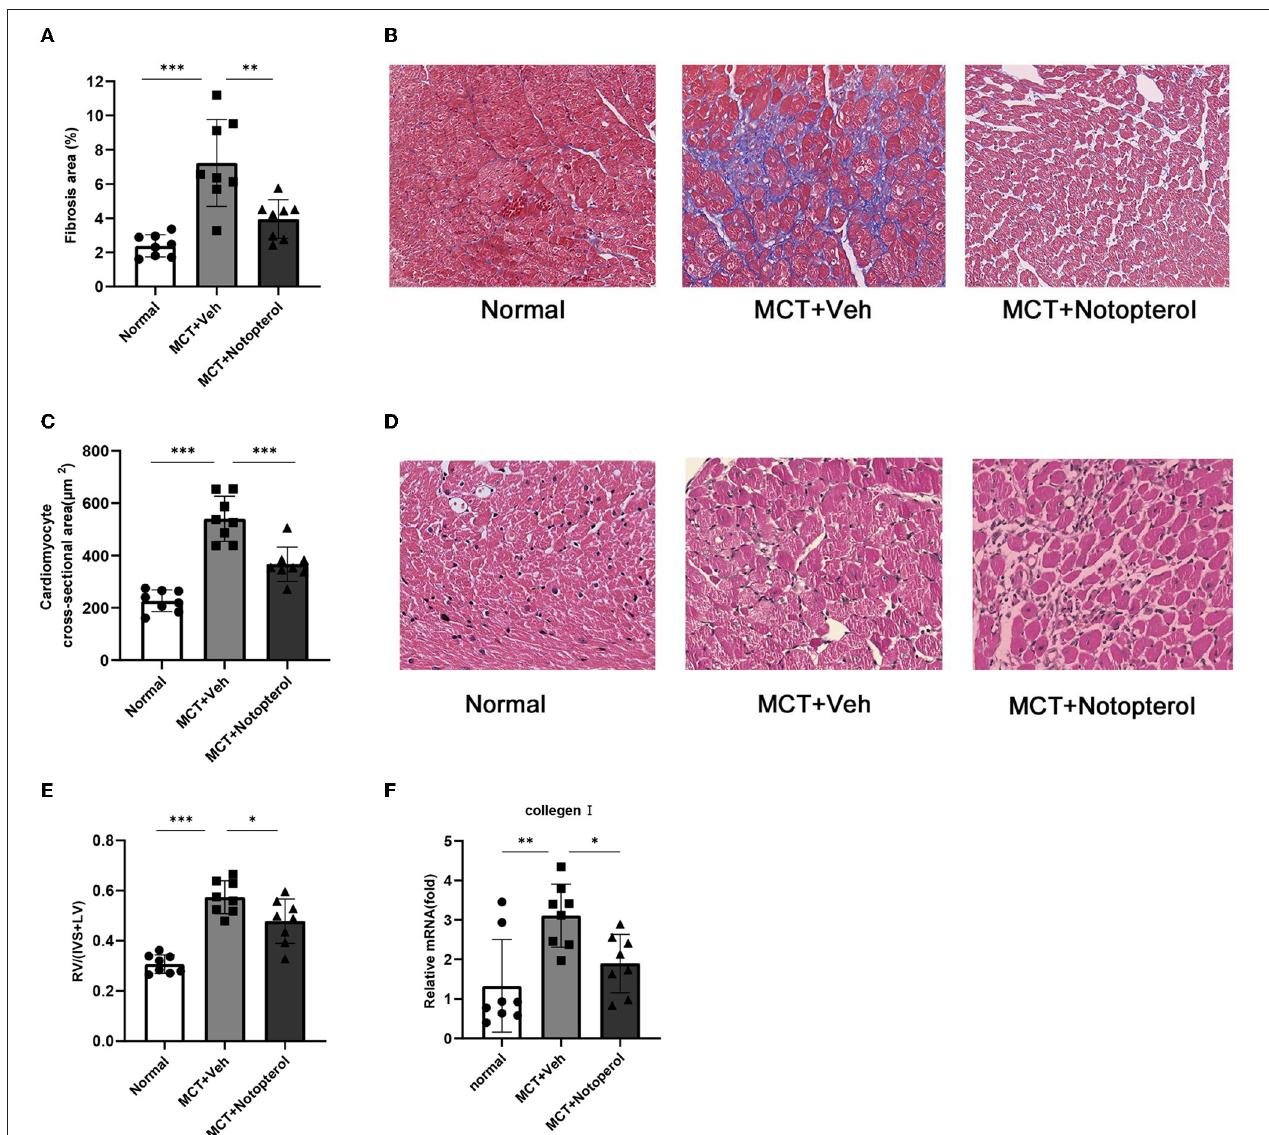
FIGURE 3 | Notopterol reduces right ventricular hypertrophy and fibrosis in pulmonary arterial hypertension rats. (A) Quantification of Masson staining; (B) Representative histopathological images of RV sections with Masson staining for collagen deposition (40 × ); (C) Quantification of Myocyte area; (D) Myocyte area. Representative cross-section cardiomyocytes (40 × ); (E) RV hypertrophy index; (F) RV mRNA expression of collagen I. ( n = 8 for each group); * p < 0.05, ** p < 0.01, *** p < 0.001. IVS, interventricular septum; LV, left ventricle.